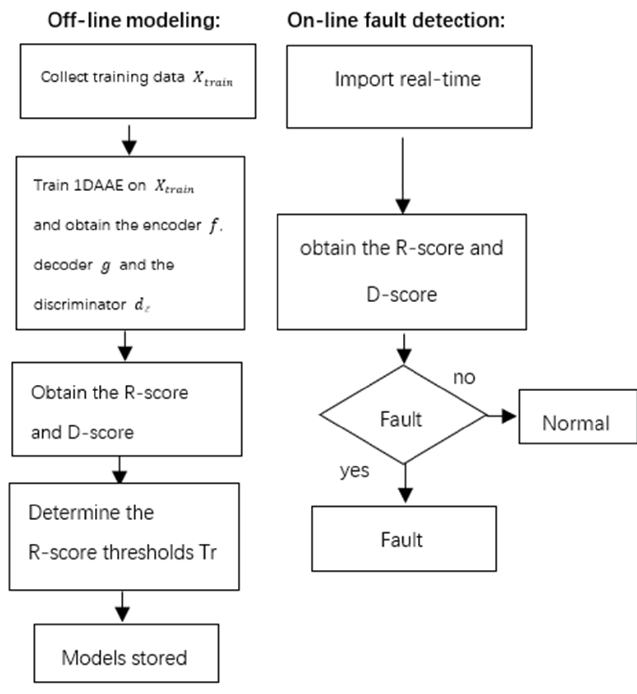
Figure 3. Flowchart of the 1DAAE-based fault detection algorithm.